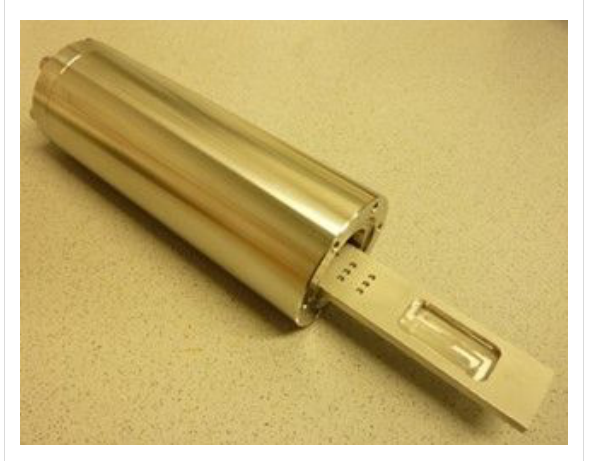
Figure 5: The tube reactor used for the chemical conversion of the golden algae.